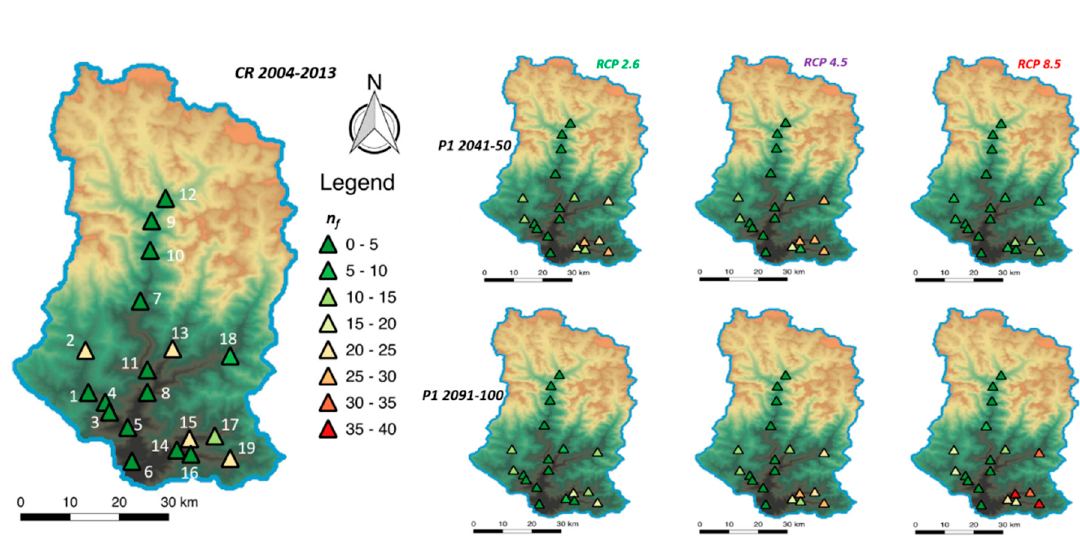
Figure 6. Designed grid. Average number of failure days n f . Control run CR , and projected future decades P1 , P2 (averages between the three models under the three RCPs, 2.6, 4.5, 8.5).